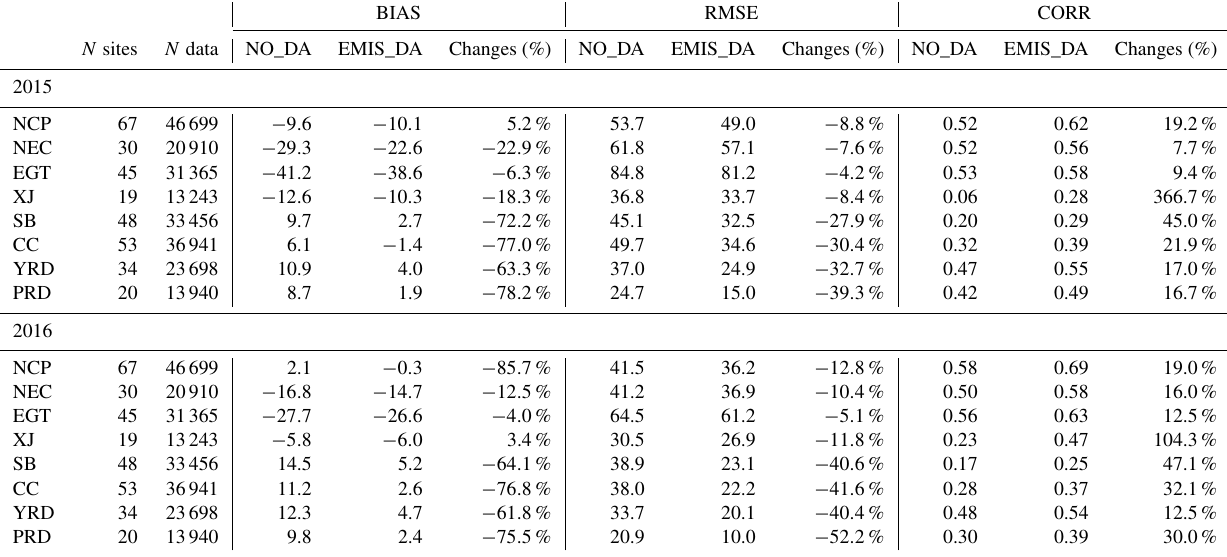
Table 5. Statistics of the EMIS_DA_FCST and NO_DA_FCST experiments in eight regions (units: µgm − 3 for BIAS and RMSE). BIAS RMSE CORR N